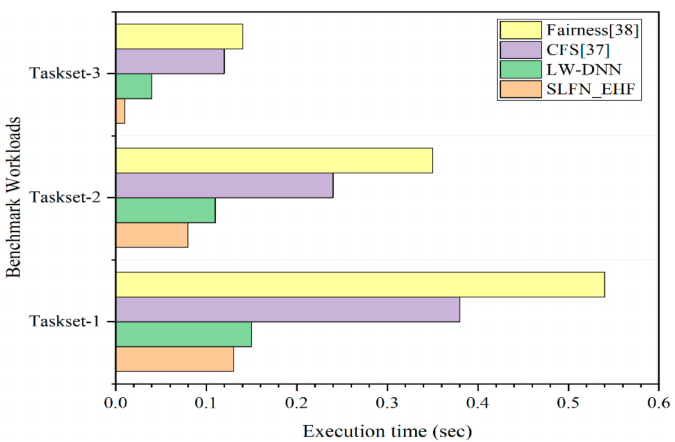
Figure 14. Overall Execution time observed on Hardware Configuration-2 for the execution of Benchmark